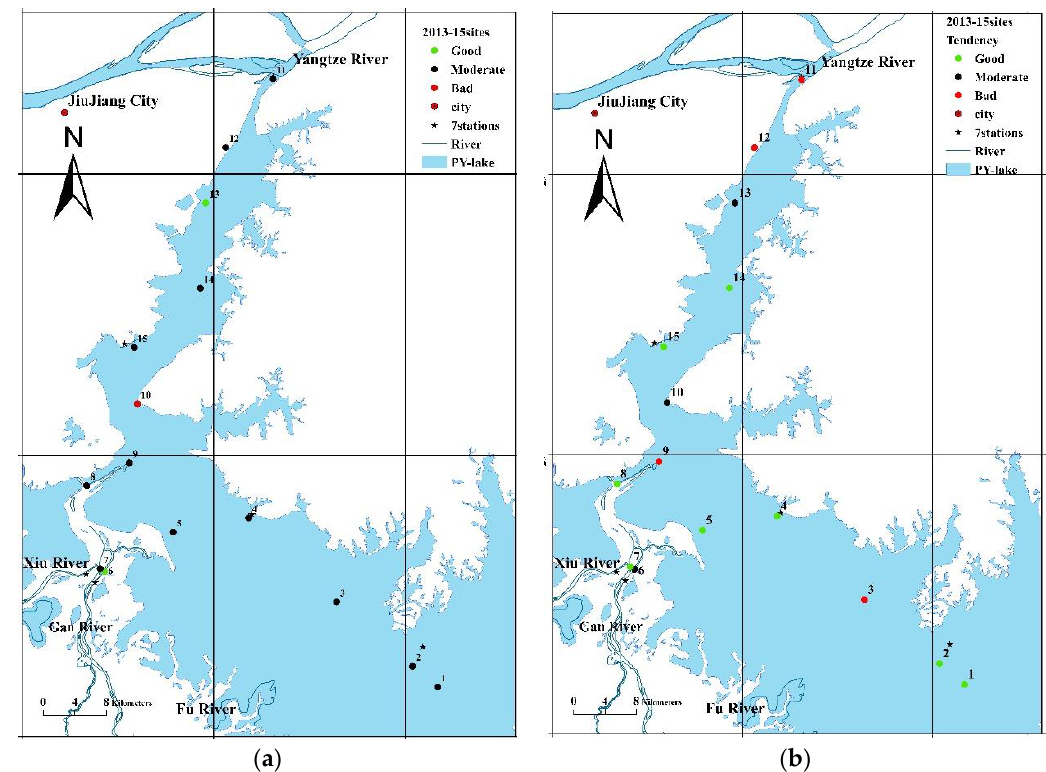
Figure 3. Aquatic ecosystem health status ( a ) and tendency ( b ) of Poyang Lake in 2013. Table 3. Aquatic ecosystem assessment results of Poyang Lake in